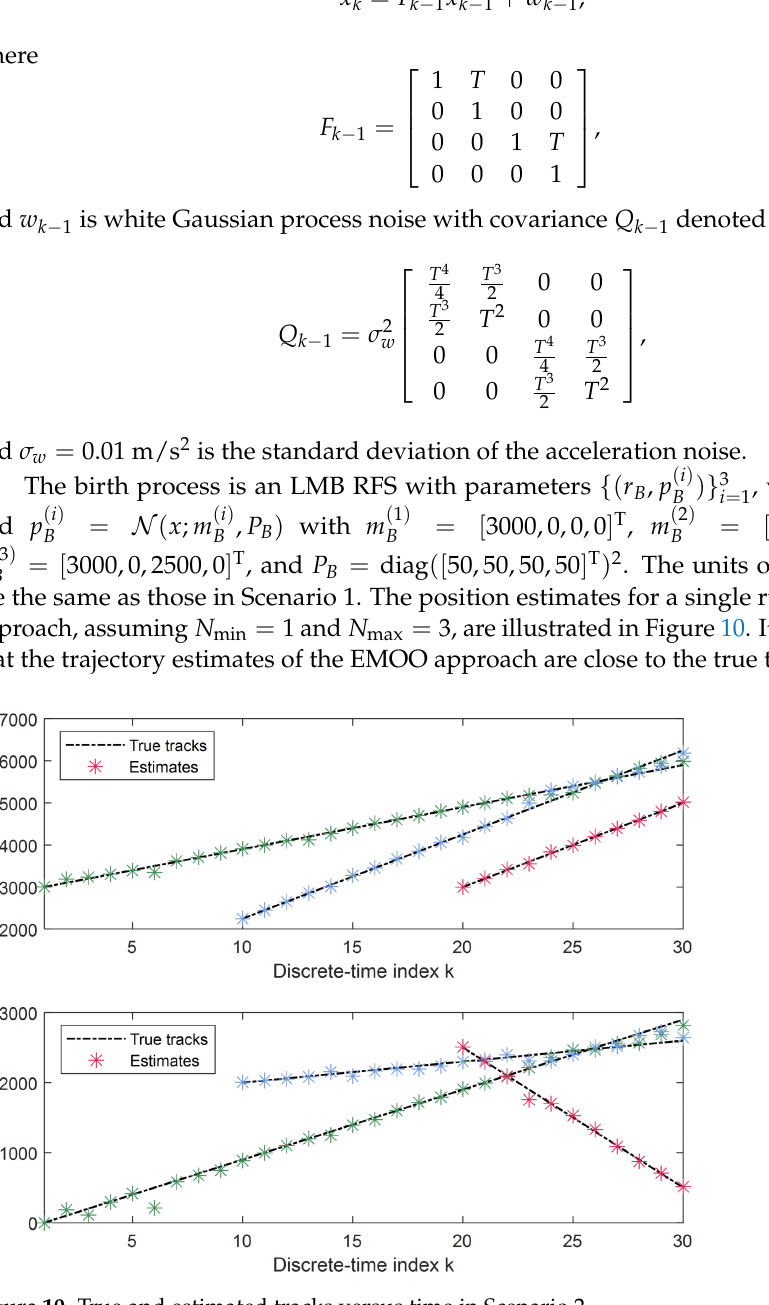
Figure 10. True and estimated tracks versus time in Scenario